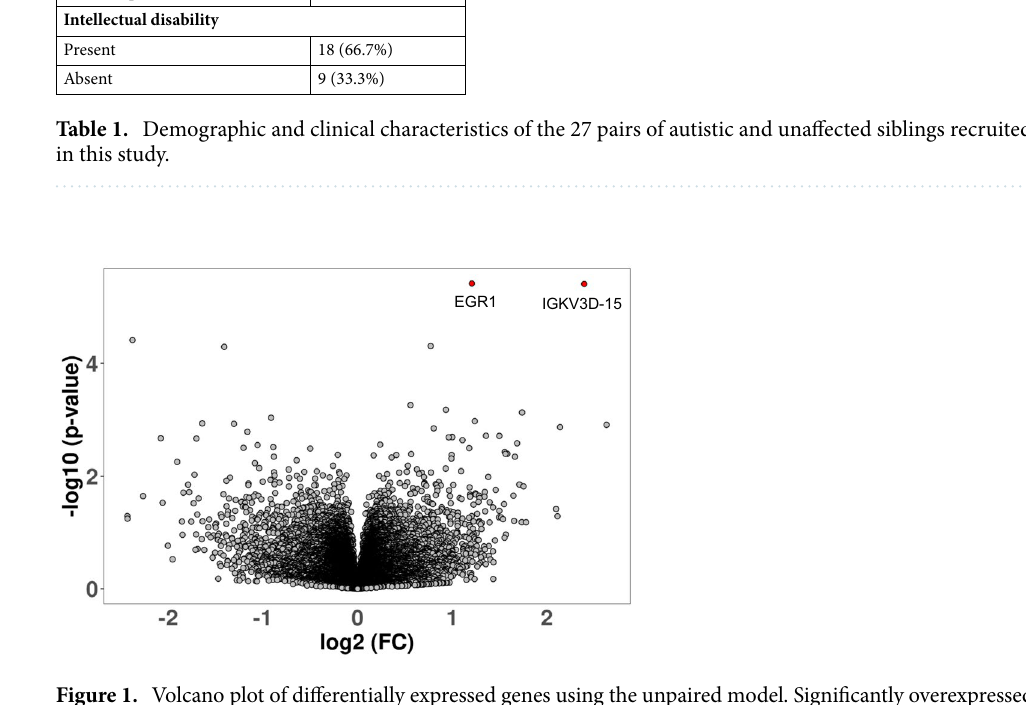
Figure 1. Volcano plot of differentially expressed genes using the unpaired model. Significantly overexpressed genes, EGR1 and IGKV3D-15 , are highlighted in